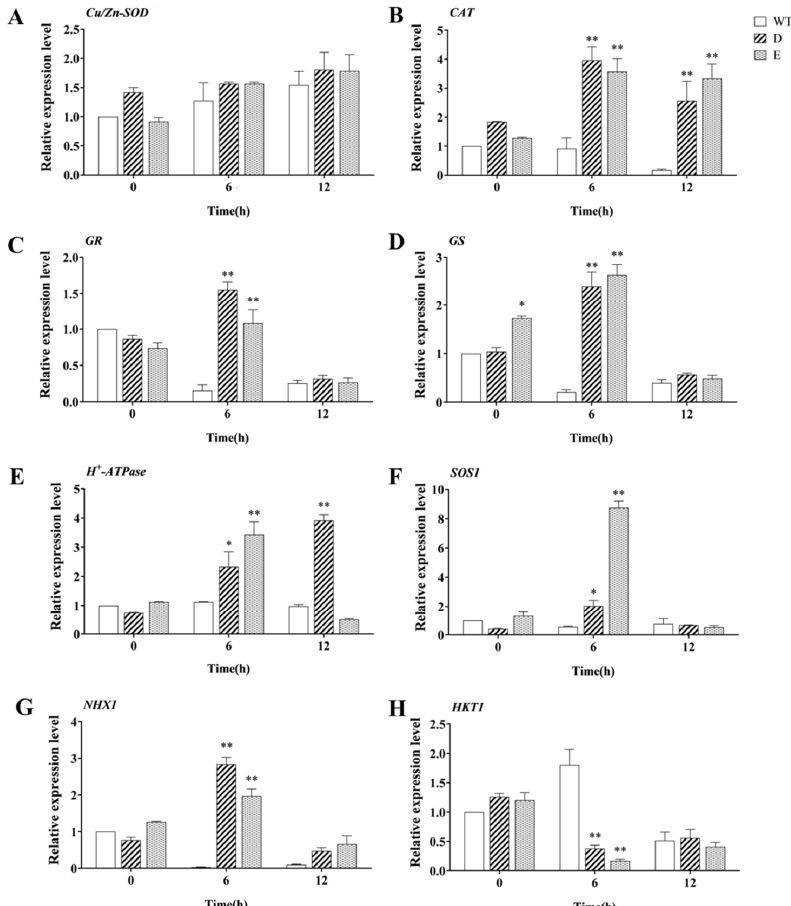
Figure 7. Relative expression of related genes under salt stress in WT and transgenic alfalfa hairy roots. The differences in the expression of genes closely related to antioxidants are shown in ( A – D ) (( A ) Cu/Zn-SOD ; ( B ) CAT ; ( C ) GR ; ( D ) GS ). The expression of H + -ATPase ( E ), SOS1 ( F ), NHX1 ( G ), and HKT1 ( H ) was also detected after and before salt stress at 6 h and 12 h. The values are the means ± SDs of three replicates (** p < 0.01; * p < 0.05).